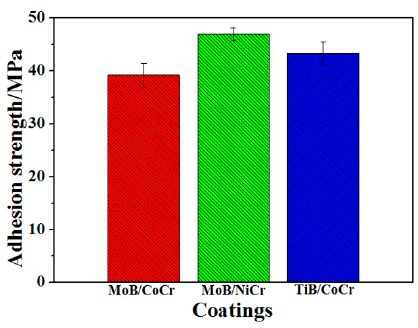
Figure 15. The microhardness of the coatings.